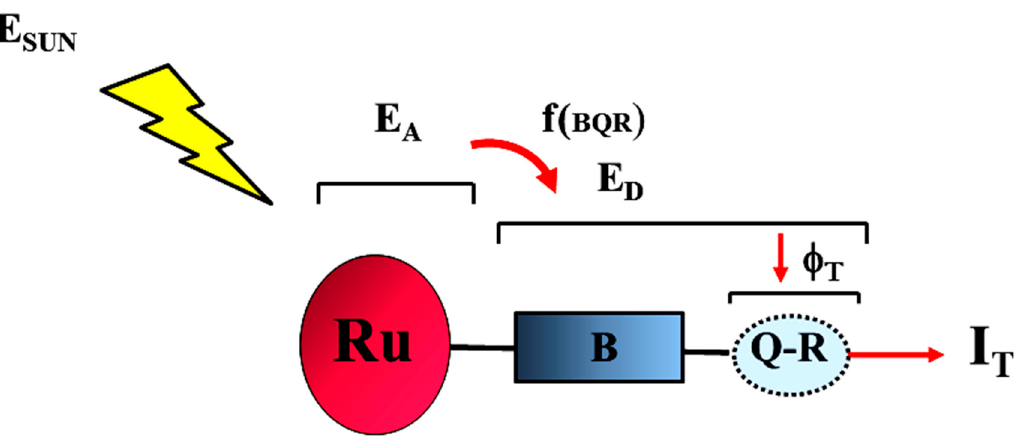
Figure 20. Description of the energy flow on a ruthenium complex containing an anchor ligand composed by BQR fragments.